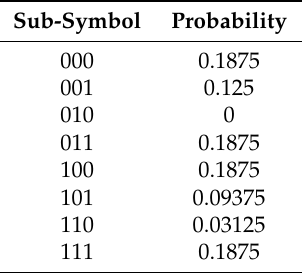
Table 3. Probability distribution of 3-bit sub-symbols.